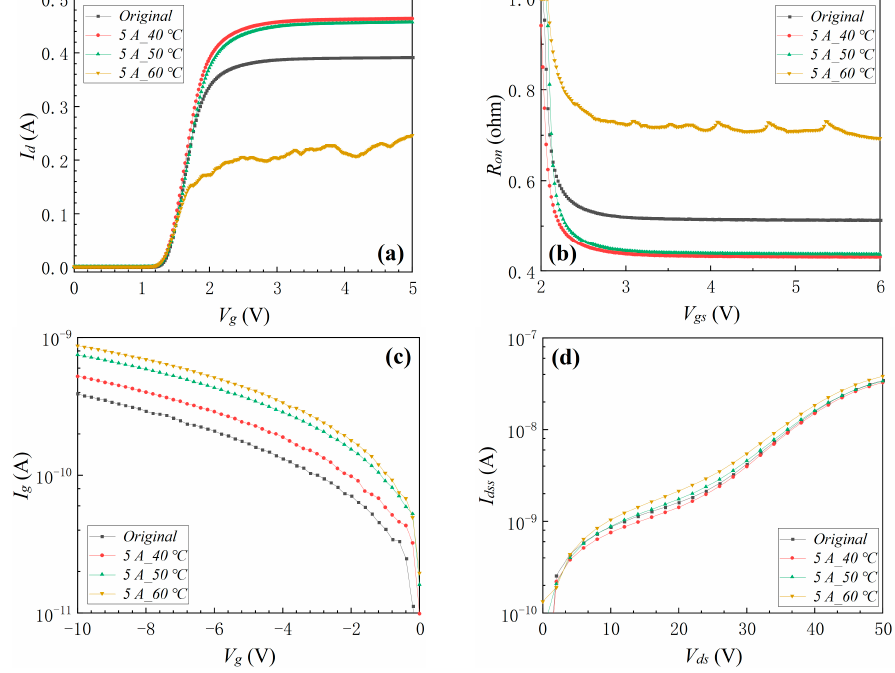
Figure 8. The device’s transfer characteristic ( a ), R on ( b ), I g ( c ), and I dss ( d ) before and after elec- tro-thermal coupling stress.